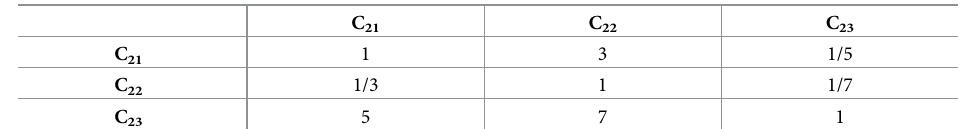
Table 6. Pair-wise comparisons of organizational factors.